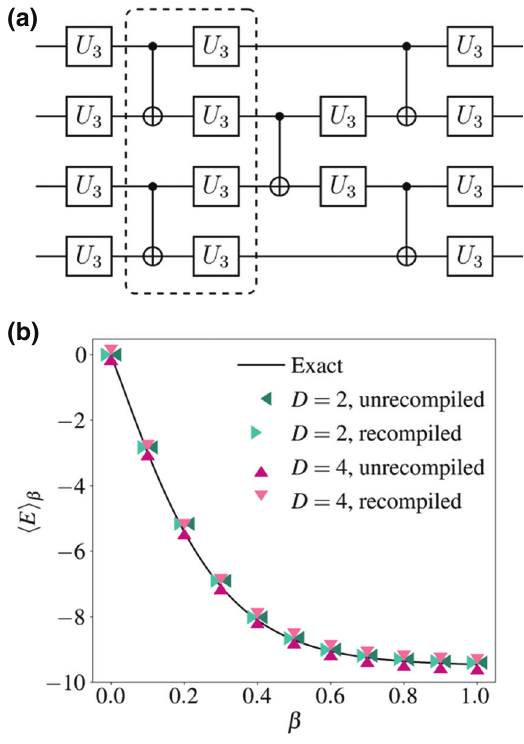
FIG. 3. (a) Four-site recompiled circuit. The four U 3 gates at the left constitute the base gate round. Each additional gate round includes a layer of CNOT gates and a layer of single-qubit gates as shown in the dashed box. The additional gate rounds alter- nate between even-odd and odd-even pairs of qubits, so that the circuit shown consists of three gate rounds. (b) Comparison of the finite-temperature energy (cid:9) E (cid:7) β of the four-site TFIM with J = 3, h = 1 with and without recompilation in the absence of noise and measurement sampling. The imaginary time step size in QITE is (cid:3)τ = 0.05. For both D = 2 and D = 4, the observ- able values from the recompiled QITE unitaries are within 0.1% of those from the unrecompiled QITE